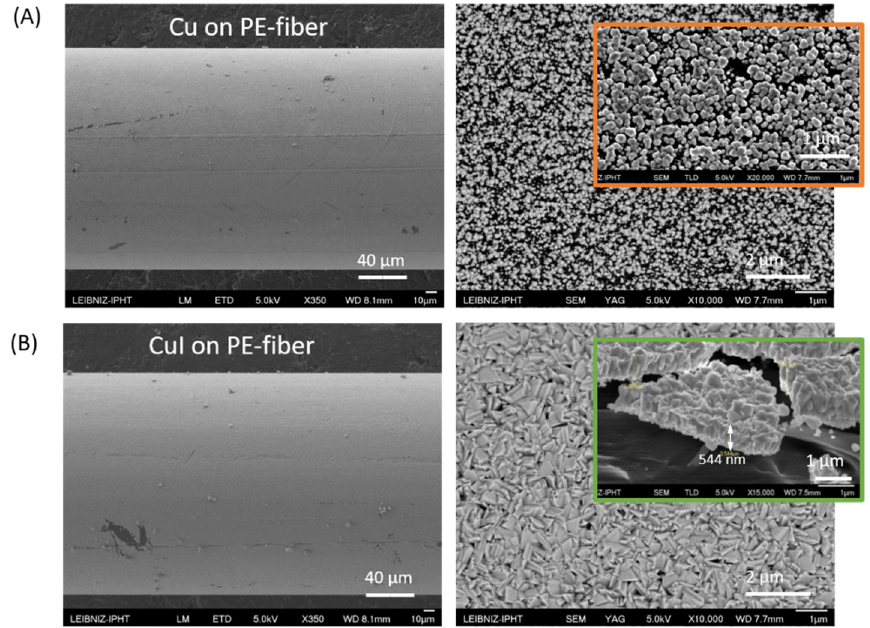
Figure 2. ( A ) Copper on polyester fiber 5 min deposition time, left: SE image, 5 kV, ×350, right: BSE image, 5 kV, ×10k. ( B ) Copper iodide coated polyester fiber, left: SE image, 5kV, ×350, right: BSE image, 5 kV, ×10k. Insets: thin film and surface structure of Cu and CuI. The BSE (backscattered electrons; Z-contrast) micrographs show no evidence of inhomogeneities.